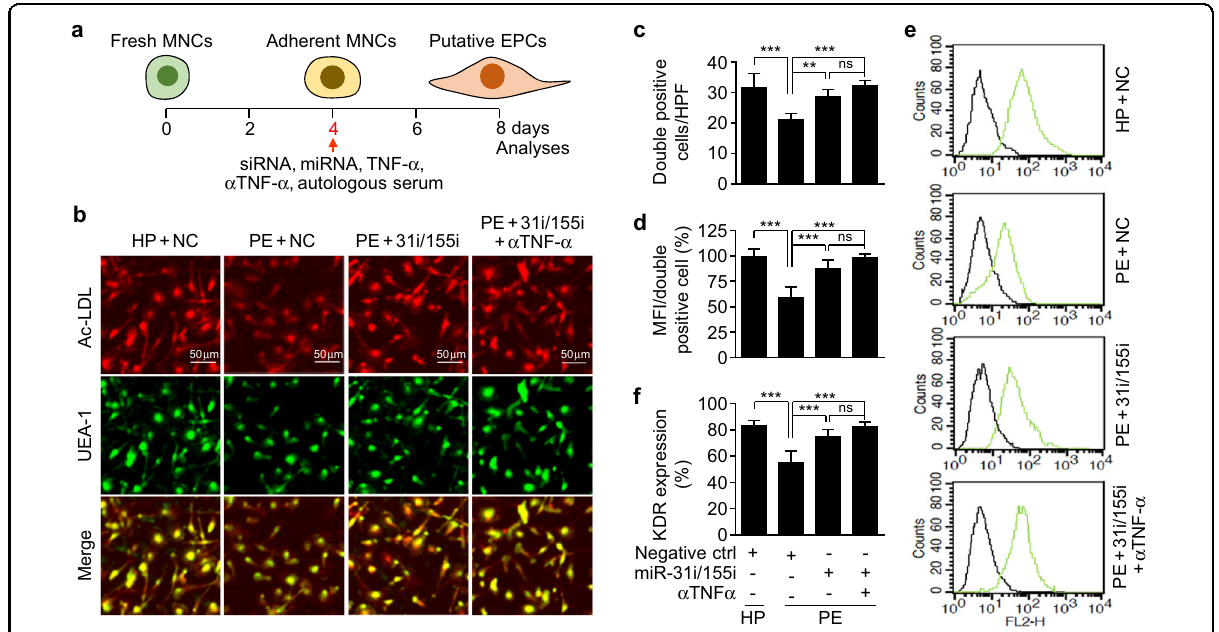
Fig. 2 Patient autologous serum-mediated suppression of EPC differentiation is prevented by inhibitors of TNF- α and miR-31/155. a Diagram depicting the protocol of EPC differentiation from MNCs and the treatment schedule. b Adherent PBMNCs from healthy pregnant (HP) and preeclamptic women (PE) were transfected with miRNA inhibitor negative control (NC) or miR-31/155 inhibitors (miR-31i/155i) and differentiated into EPCs in autologous serum-supplemented culture media with or without a human TNF- α -neutralizing antibody ( α TNF- α ). EPCs were identi fi ed by confocal microscopy after staining with Dil-ac-LDL and FITC-UEA-1. c The number of double-positive (yellow) cells per high-power fi eld (HPF) was counted. d The mean fl uorescence intensity (MFI) of double-positive cells was quantitated for each cell using ImageJ software. e , f The expression levels of KDR were quantitated by fl ow cytometry. P < 0.05, ** P < 0.01, and *** P < 0.001. ns not signi fi